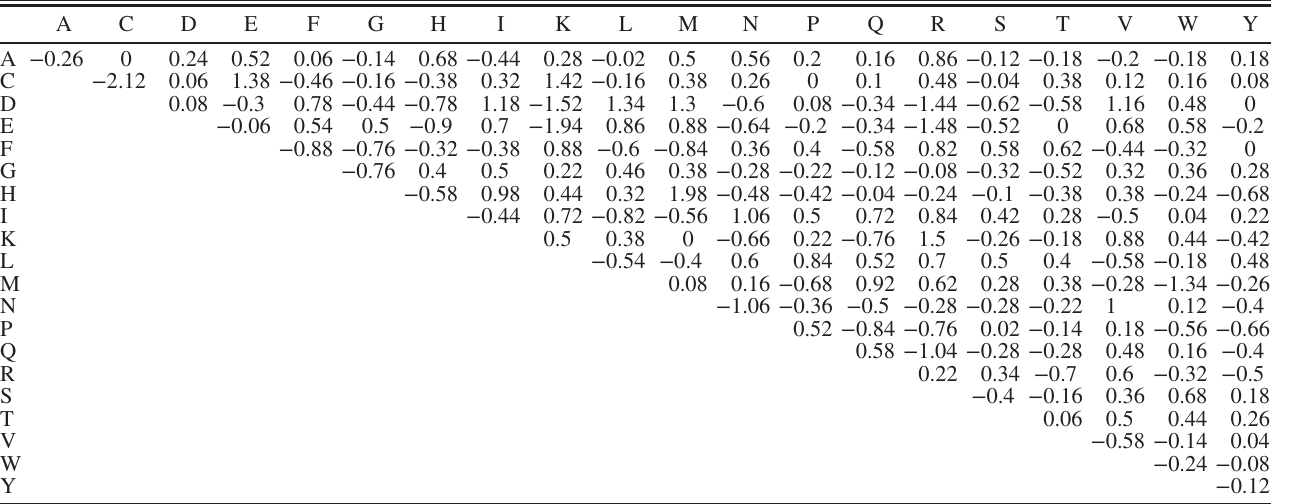
TABLE I. Residue-residue interaction energy expressed in internal units.